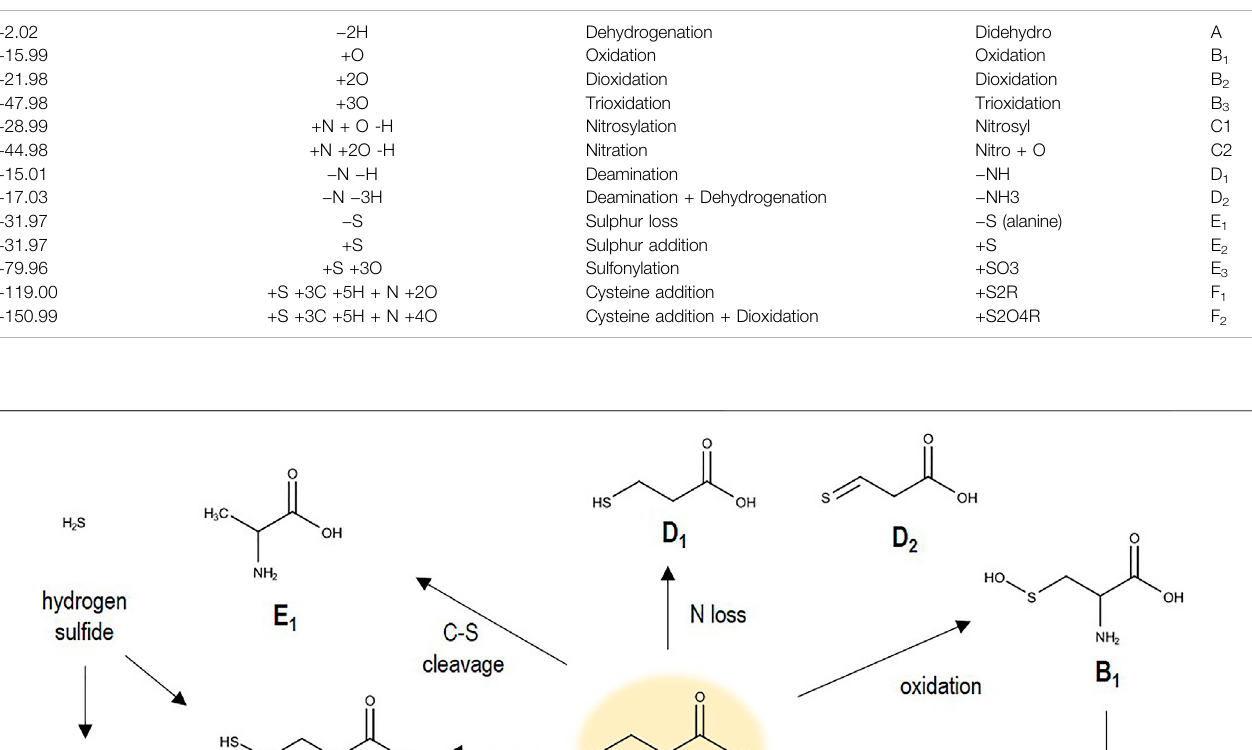
TABLE 1 | Analyzed thiols oxidative modi fi cations occurring in the proteome of plasma treated porcine skin samples. Mass shift (Da) Label